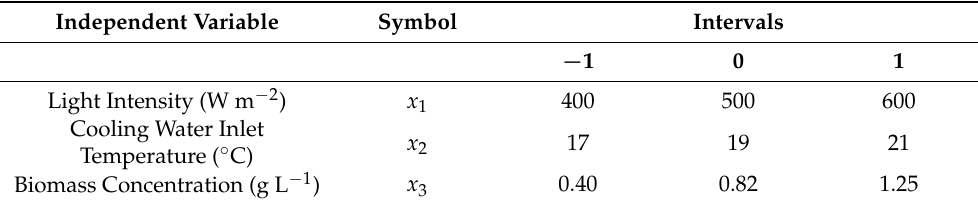
Table 1. Symbols and intervals used in response surface methodology. Independent